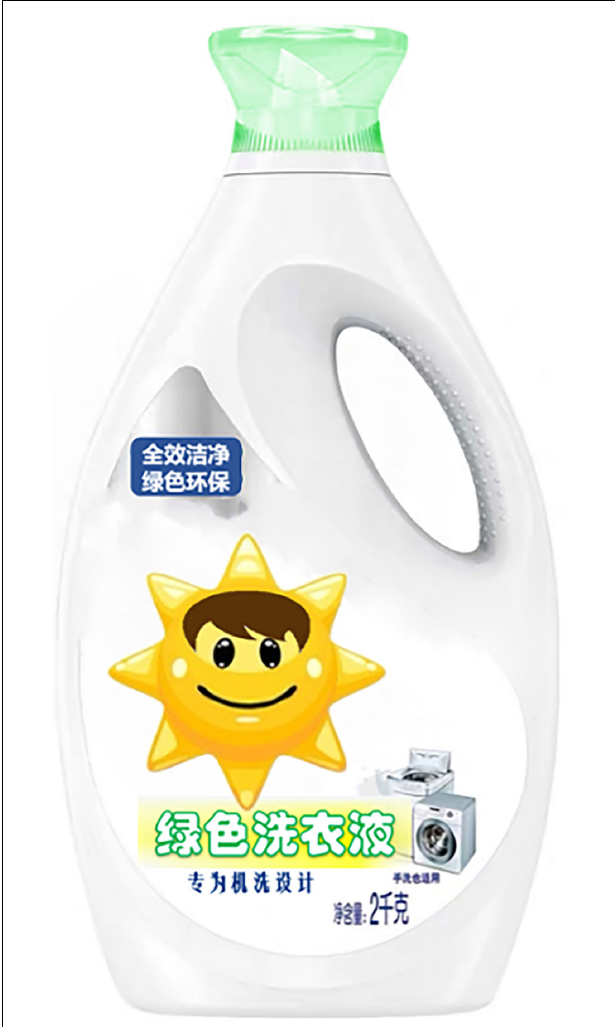
FIGURE 6 | Anthropomorphic strategy of happy expressions with eyes.